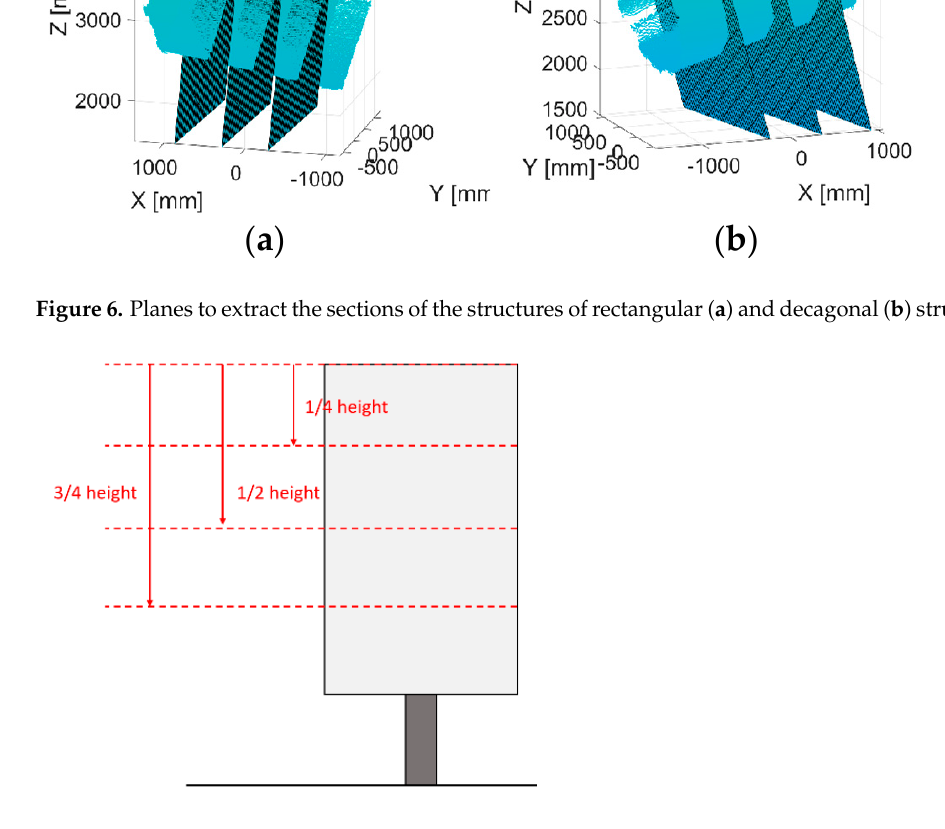
Figure 7. Schematic diagram showing the height of the sections.